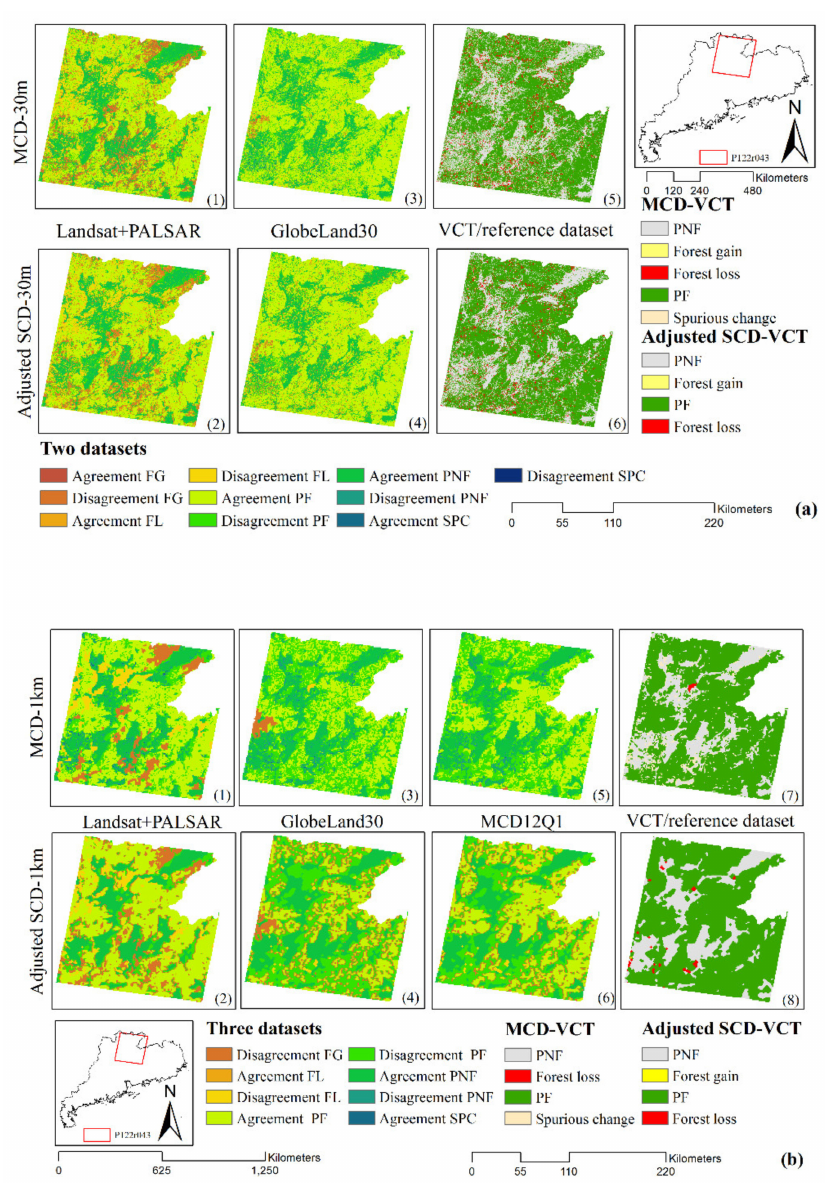
Figure 3. Maps of forest cover change (p122r043) spatial agreement (SA) and disagreement (SD) assessments at 30-m resolution (( a )-1, 2, 3, 4) and 1-km resolution (( b )-1, 2, 3, 4, 5, 6) using the VCT-based results (( a )-5, 6 and (( b )-7,8) as a reference dataset among the algorithm-based